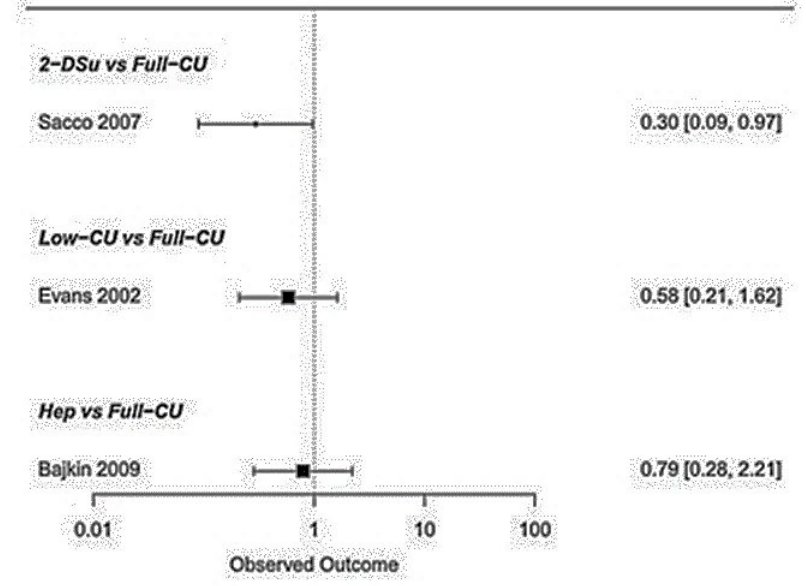
Figure 5. Intervention comparison regarding the different anticoagulants’ protocols [10–12].